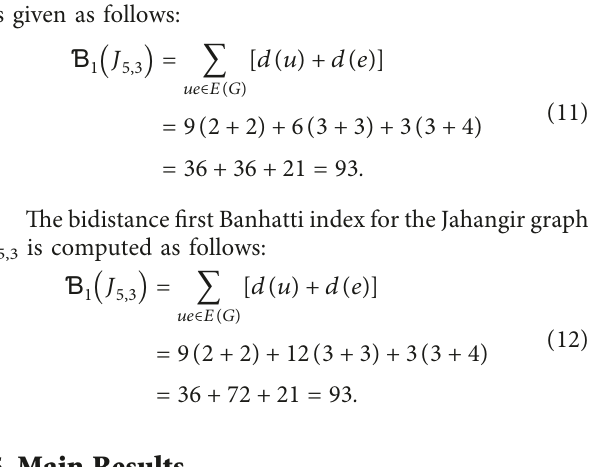
Figure 2: Jahangir graph J